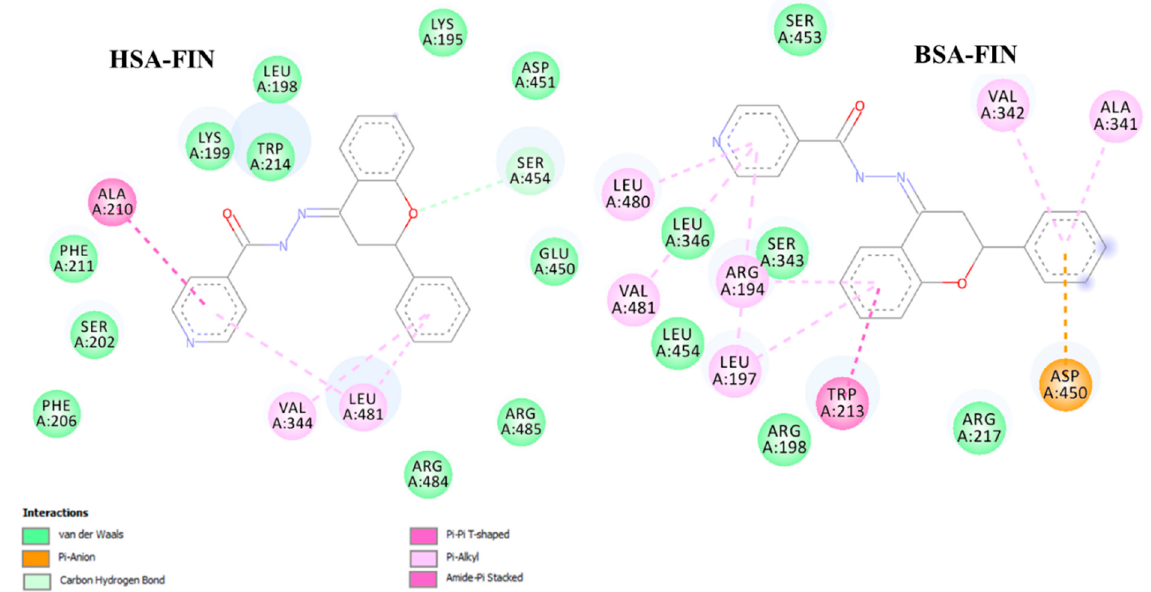
Figure 9. Graphical representation of the binding site for the lowest energy conformation of HSA – and BSA – FIN complex.